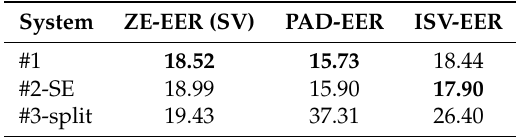
Table 3. Results of various architectures using the proposed monolithic E2E framework for the ISV task. Numbers in bold represent the best results. Numbers in bold represent the best